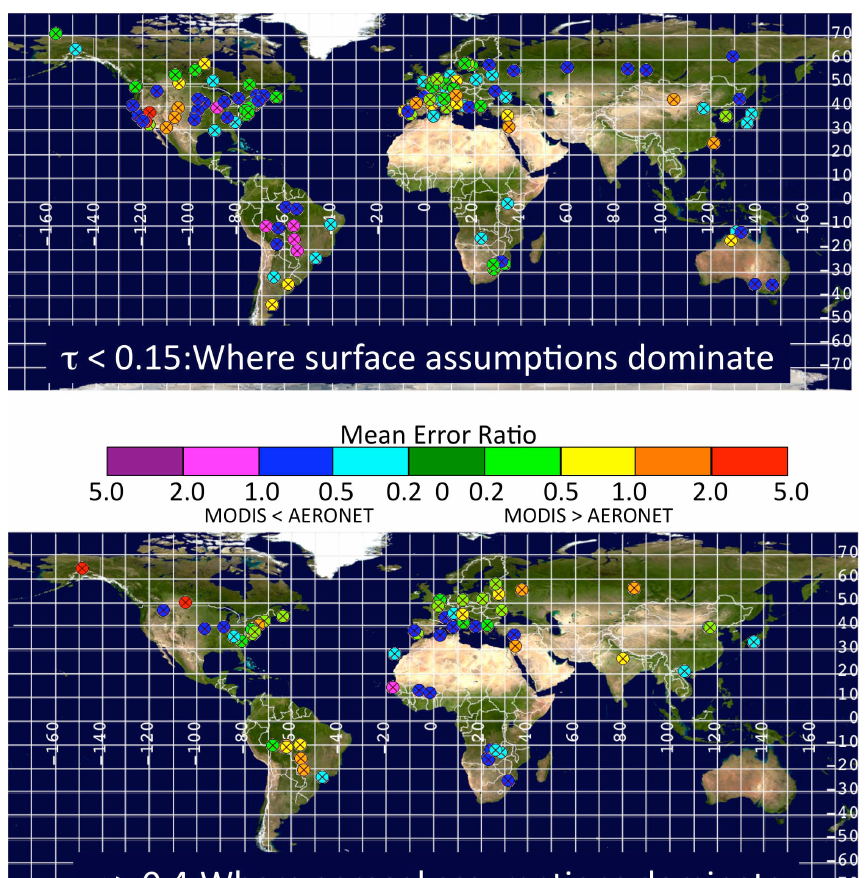
Fig. 5. “Quality” of MODIS/AERONET 0.55µm AOD comparison at each AERONET site during June–July–August, for cases where AERONET AOD < 0.15 (top) and AERONET AOD > 0.4 (bottom). Sites are color-coded based on the average error ratio (Error/EE). Greenish colors (Cyan and Lime) are sites where the average of the MODIS and AERONET-derived AOD values differ by less than half of EE. Colder (warmer) colors represent cases where MODIS, on average, significantly underestimates (overestimates)